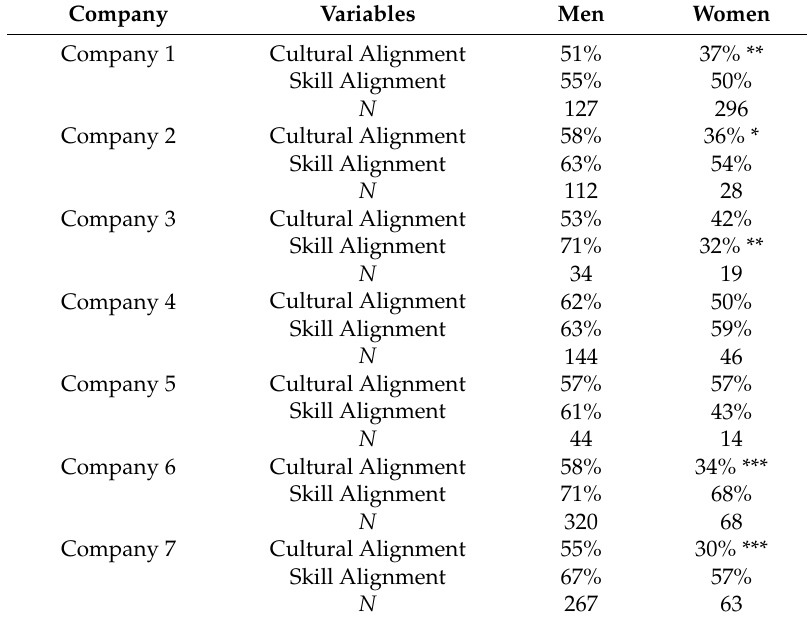
Table A6. Percent of Men and Women who have Cultural and Skill Alignment by Company.